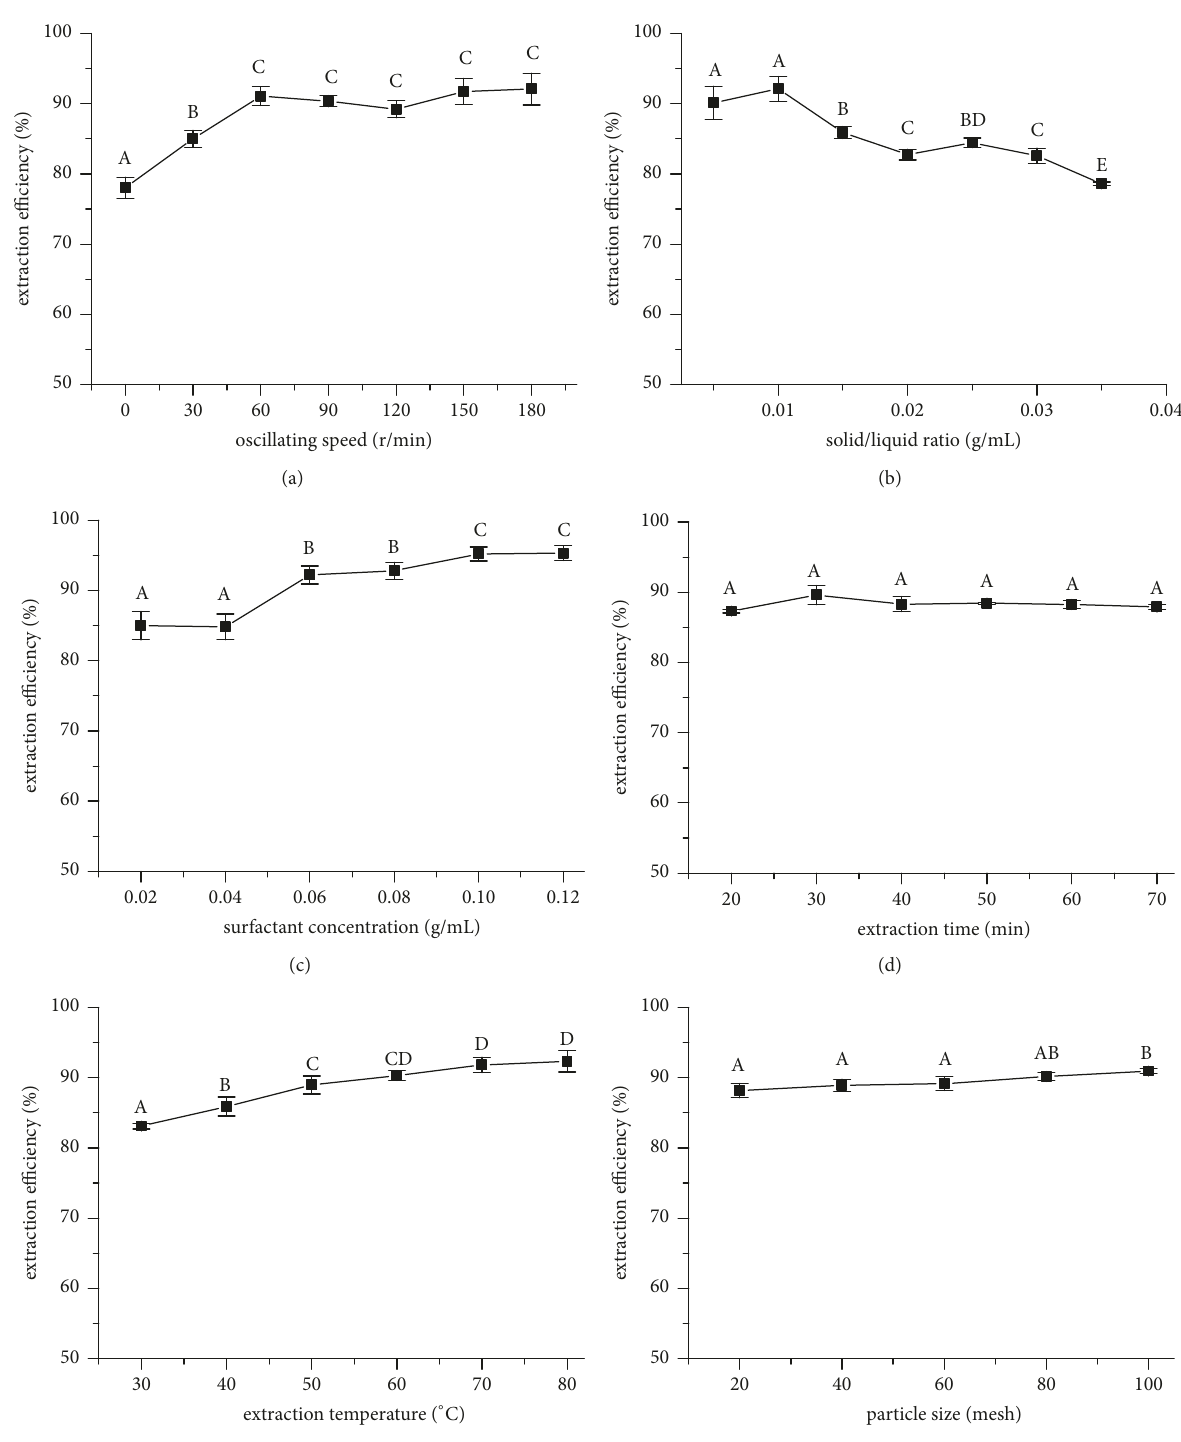
Figure 2: Effects of various factors on the extraction efficiency of soybean oil: (a) oscillating speed; (b) solid/liquid ratio; (c) surfactant concentration; (d) extraction time; (e) extraction temperature; (f) particle size of soya bean flour. Note. Different small letters (A–D) mean significant difference at 𝑃 < 0.05